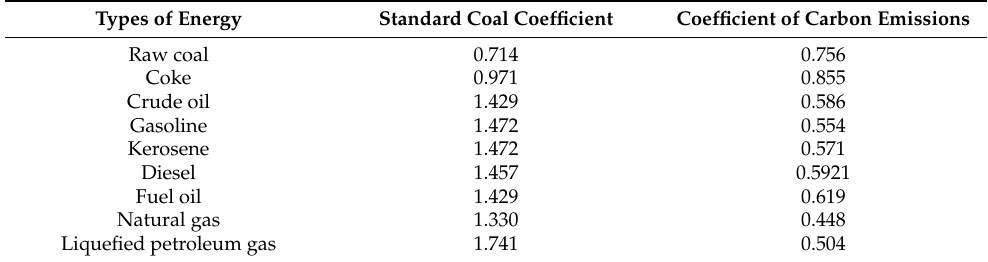
Table 1. Standard coal coefficient and coefficient of carbon emissions of the energy